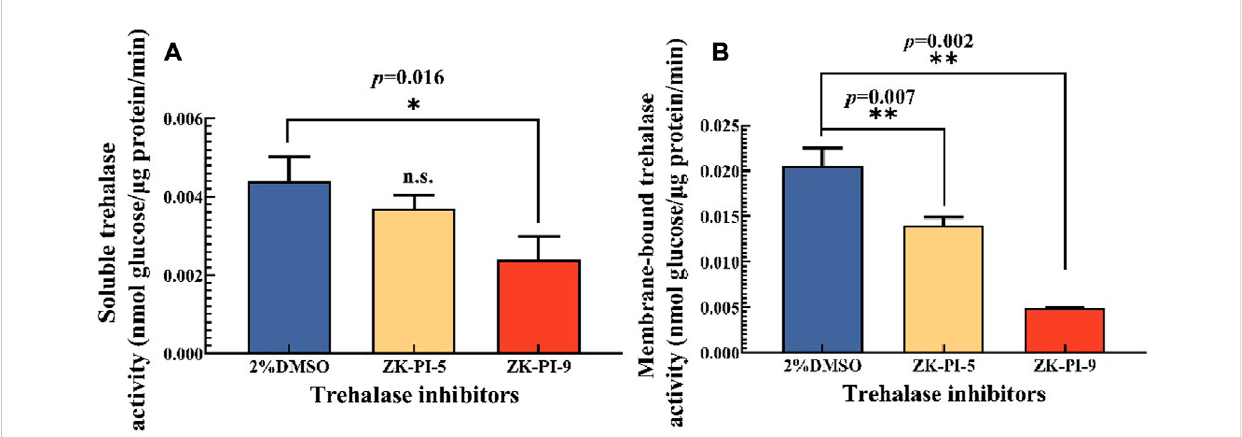
FIGURE 1 Changes in trehalase activity 48 h after injecting two trehalase inhibitors. (A) Change in soluble trehalase activity; (B) Changes in membrane-bound trehalase. The S . frugiderda larvae on the fi rst day of the third instar were divided into three parallel groups, injected with two trehalase inhibitors or left untreated, and used to detect trehalase activity after 48 h. Values are presented as the means ± SE. * p < 0.05 denotes signi fi cant differences. ** p < 0.01 denotes extremely signi fi cant differences, n.s.: not signi fi cant (independent-samples t -test).